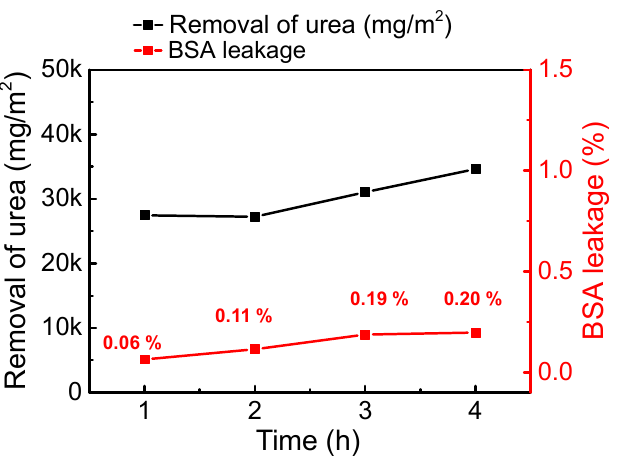
Figure 8. Removal of urea from synthetic human plasma by DHF-520 membrane during one session.